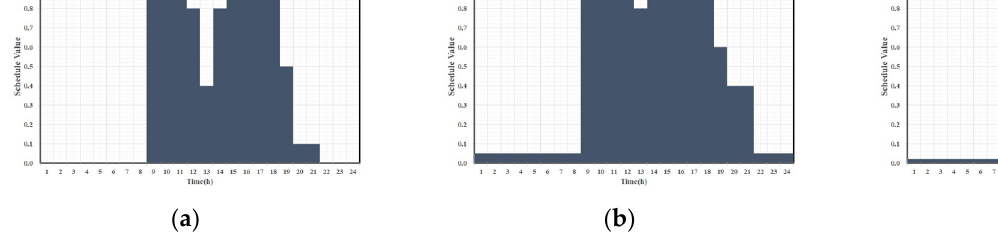
Figure 2. Internal heat gain schedules: ( a ) Occupancy; ( b ) Lighting; ( c ) Equipment.